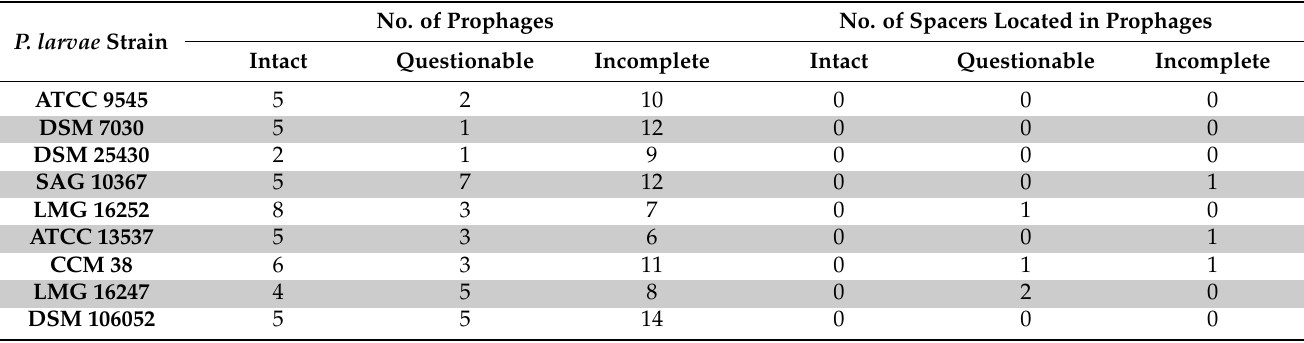
Table 3. No spacers were found in intact prophages; only three spacers were found in incomplete prophages; and four in questionable prophages. Considering the number of spacers and the number of prophages in P. larvae strains, the number of spacers in pro- phage regions is extremely low. Table 3. Number of prophages in P. larvae strains and number of spacers located in prophage regions. P. larvae Strain